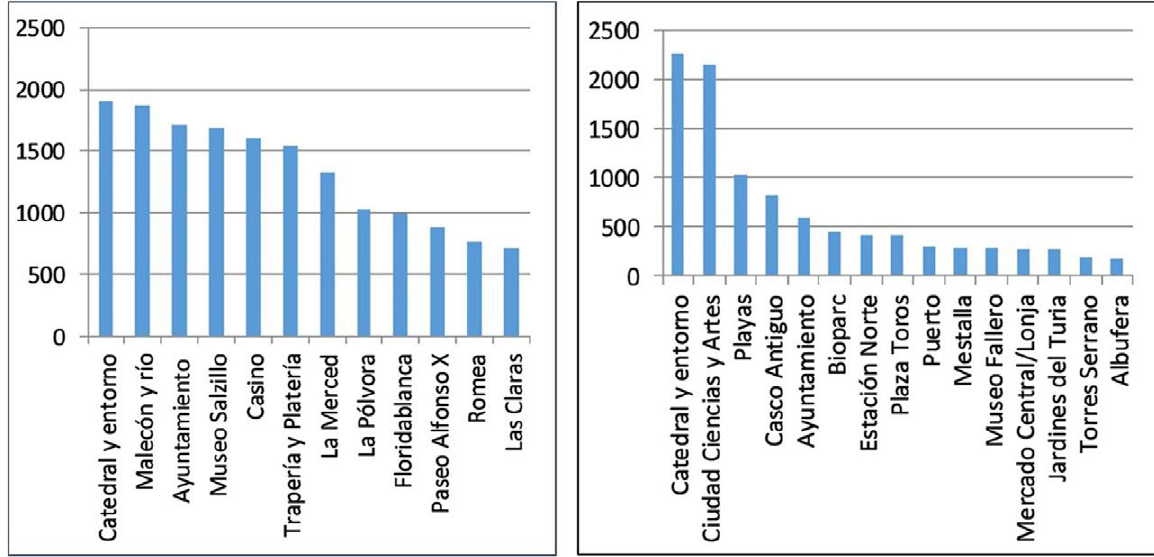
Fig. 10. Places to show to other visitors, the scores assigned according to the responses of the surveys in Murcia (left) and Valencia